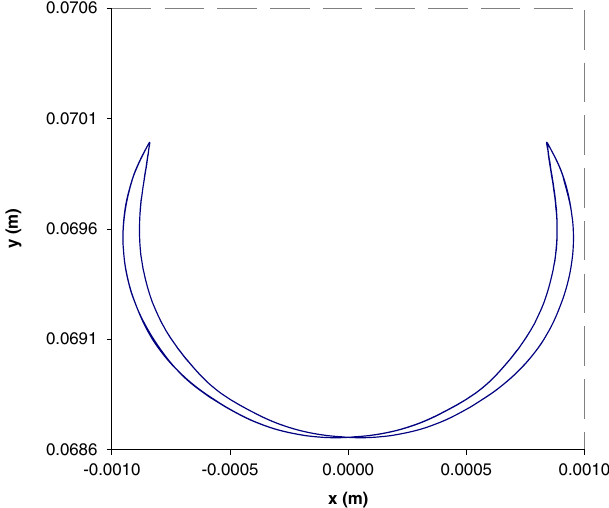
FIG. 3. An example of a resonant trajectory in the iris of a dipole cavity, calculated using the tracking code, for a 70 mm radius iris, rf frequency of 800 MHz, and a magnetic field of 54